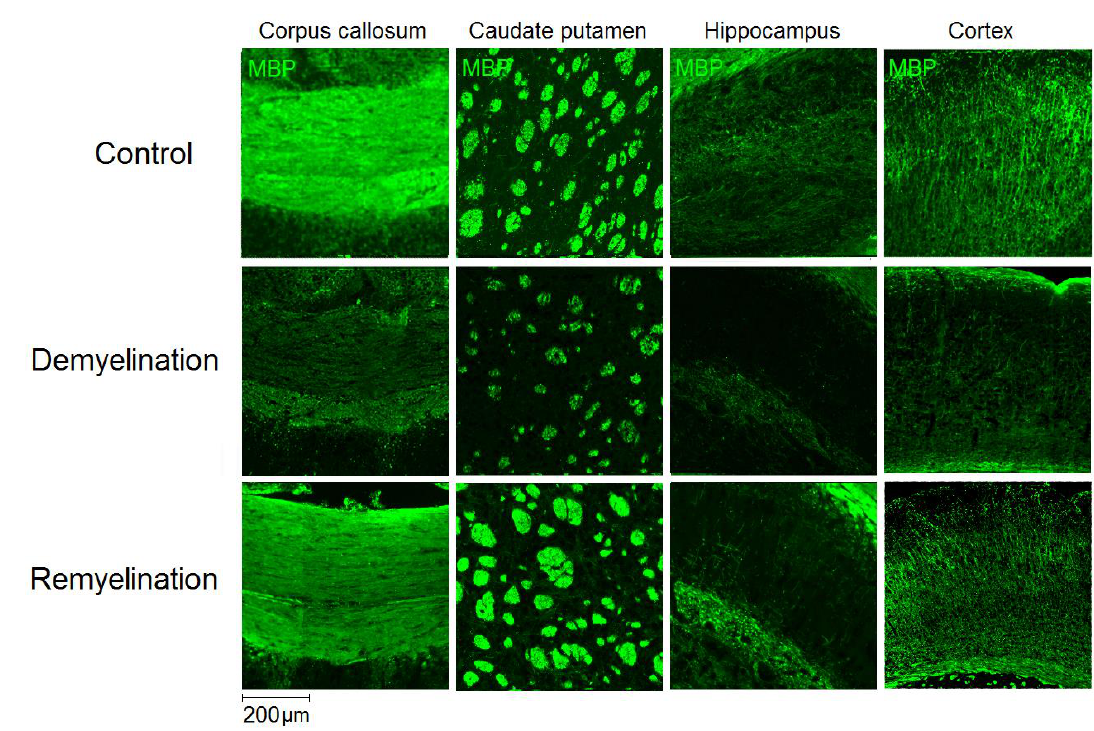
Figure 3. Effect of cuprizone-induced demyelination and remyelination after cuprizone discontinuation on MBP immunostaining. Example microphotographs of MBP-stained sections are presented for the corpus callosum, caudate putamen, cortex, and hippocampus with magnification of ×100.